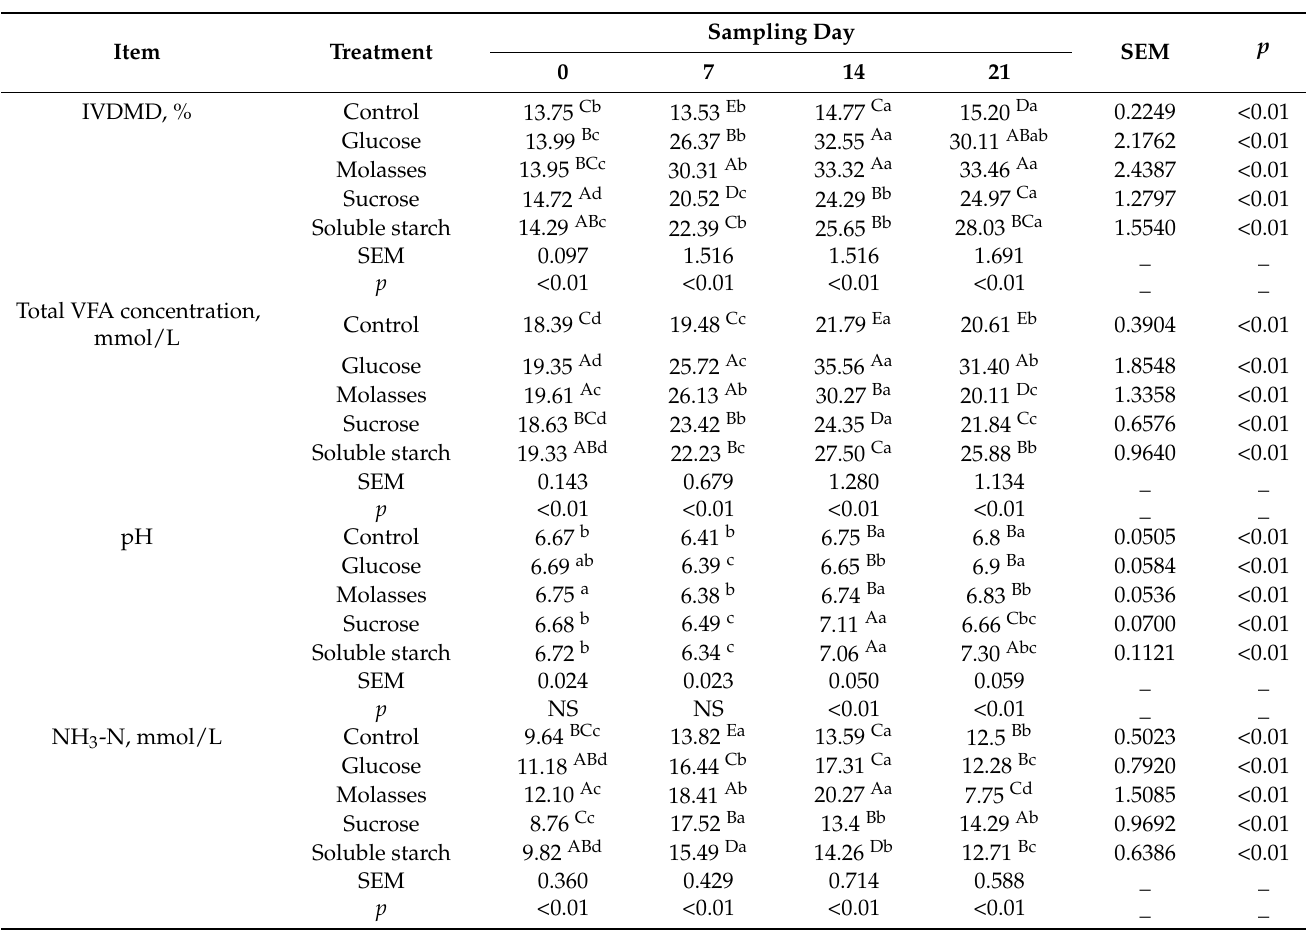
Figure 2. Loss rate of cellulose, hemicellulose, and lignin from rice straw during 21 days of solid–state fermentation with Phanerochaete chrysosporium . ( A ) Cellulose loss rate. ( B ) Hemicellulose loss rate. ( C ) Lignin loss rate. Table 5. In vitro fermentation characteristics of corn stover.